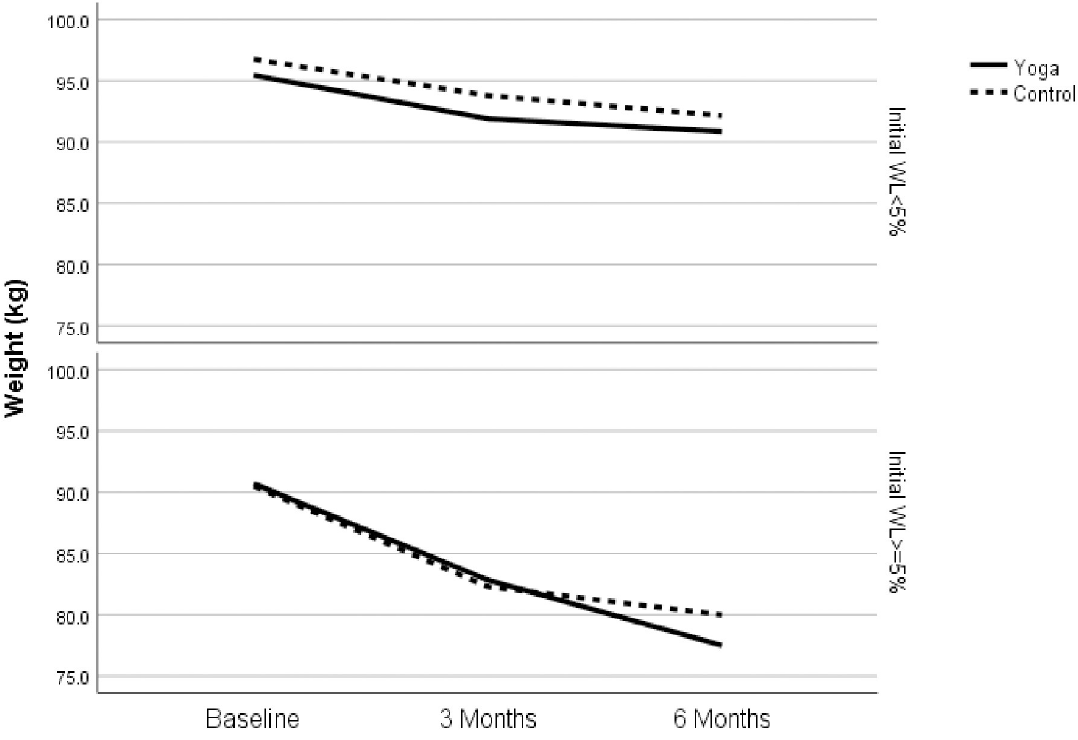
Fig 2. Adjusted median weight change over time by treatment arm and initial weight loss category. Initial weight loss is defined as percent weight loss achieved during behavioral weight loss treatment (3-month weight loss).